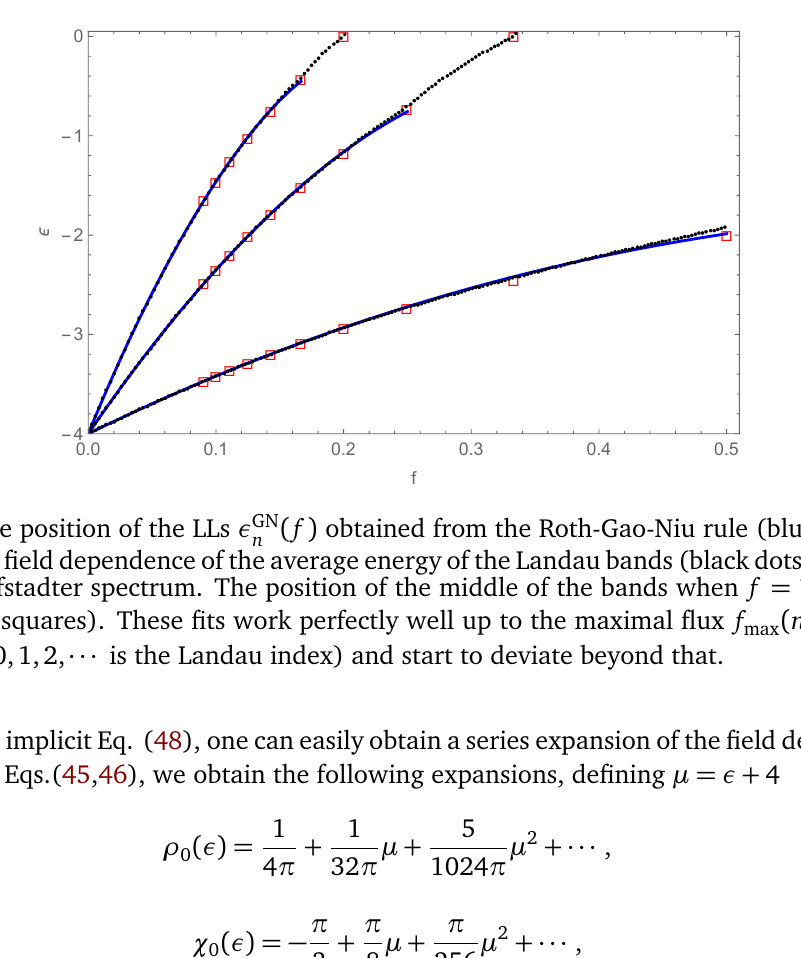
Figure 6: Bottom part of Hofstadter spectrum (energy as a function of the flux per plaquette). The dashed blue lines are the three first LLs ( n = 0,1,2) obtained from the usual Onsager semi-classical quantization rule with the exact zero-field IDoS. The blue lines are obtained from the Roth-Gao-Niu rule with the susceptibility correction Eq.(48). Semi-classical LLs are = 1 . The color code for the Hofstadter energy levels plotted up to a maximum flux f max 2 ( n + 1 ) obtained for rational values of f = p / q with q = 349 separate the lower half of the energy levels (black) from the upper half (red).